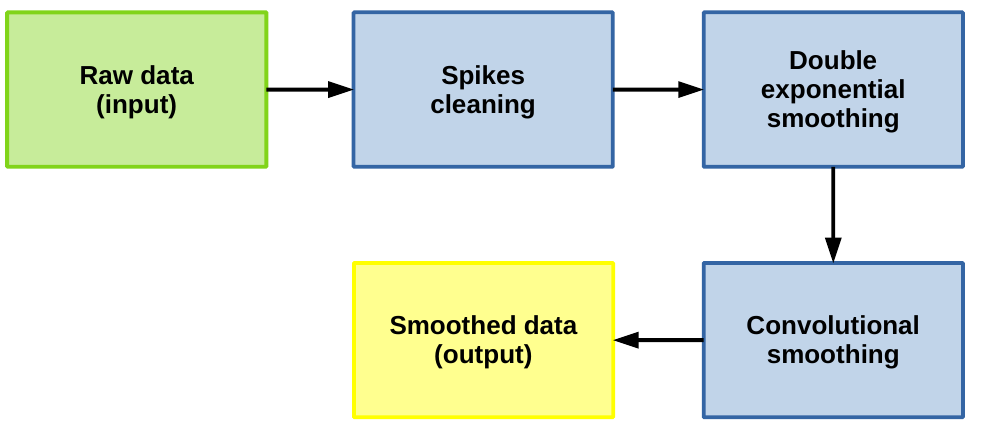
Figure 1. Pre-processing flow